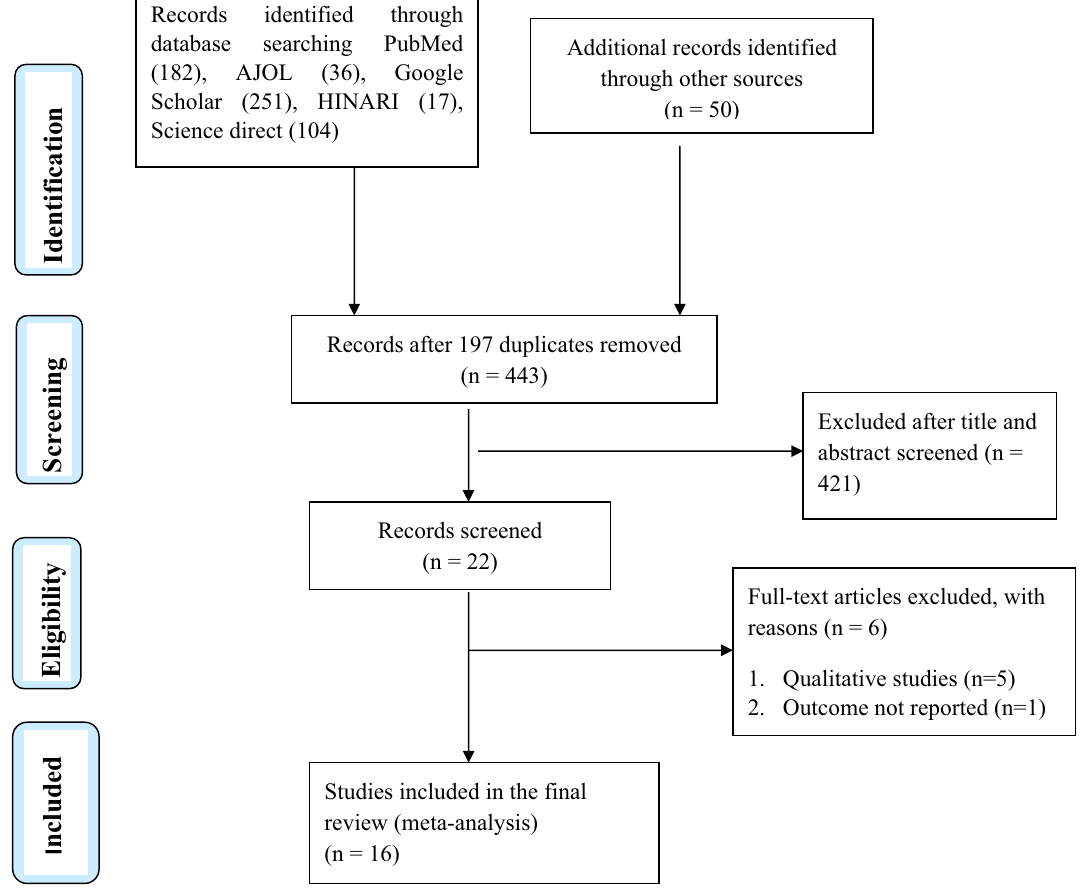
Figure 1. A PRISMA flow chart explaining the selection of primary studies for systematic review and meta- analysis of food taboo practices among pregnant women in